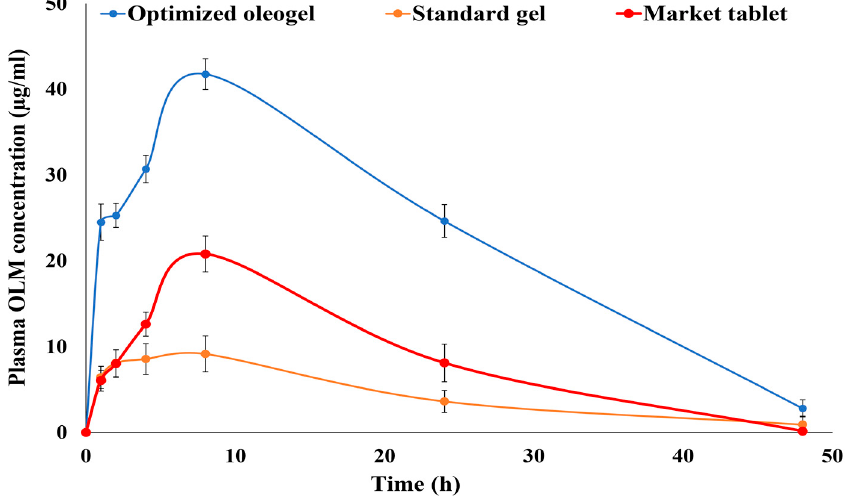
Figure 11. Mean plasma concentrations of olmesartan after a single transdermal application of the optimized oleogel, standard gel, and oral administration of the market product (Angiosartan ® Tablets), each equivalent to 0.36 mg drug. Presented data are the mean ± SD (n = 3).